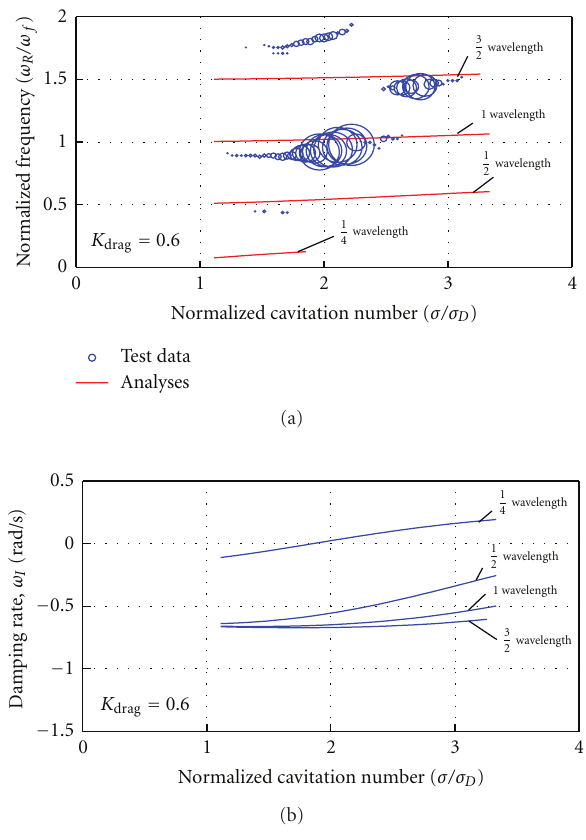
Figure 9: (a) Comparison of frequency between experimental results and analytical results ( ω R ) using CFD-calculated K and M . (b) Analytical results of damping rate ( ω calculated K and